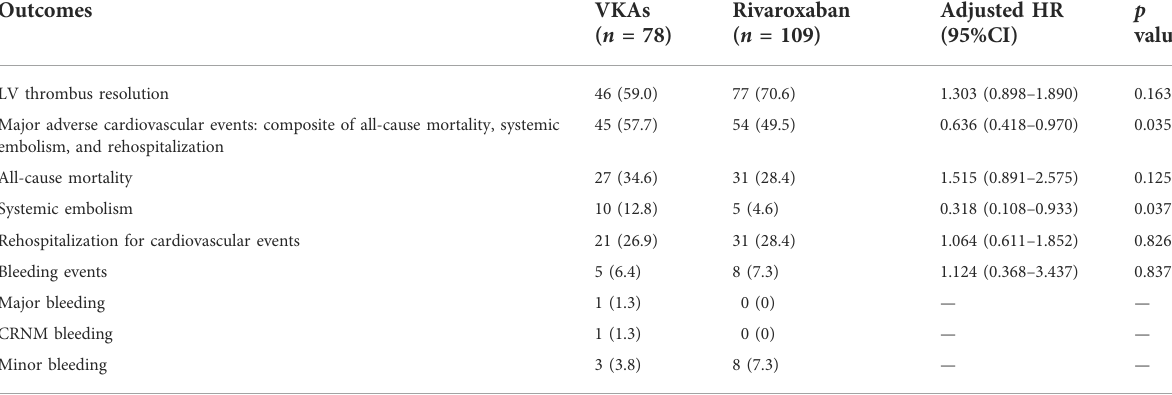
TABLE 2 Outcomes of Cox Proportional Hazards Regression Analysis in Patients who received Rivaroxaban or VKAs